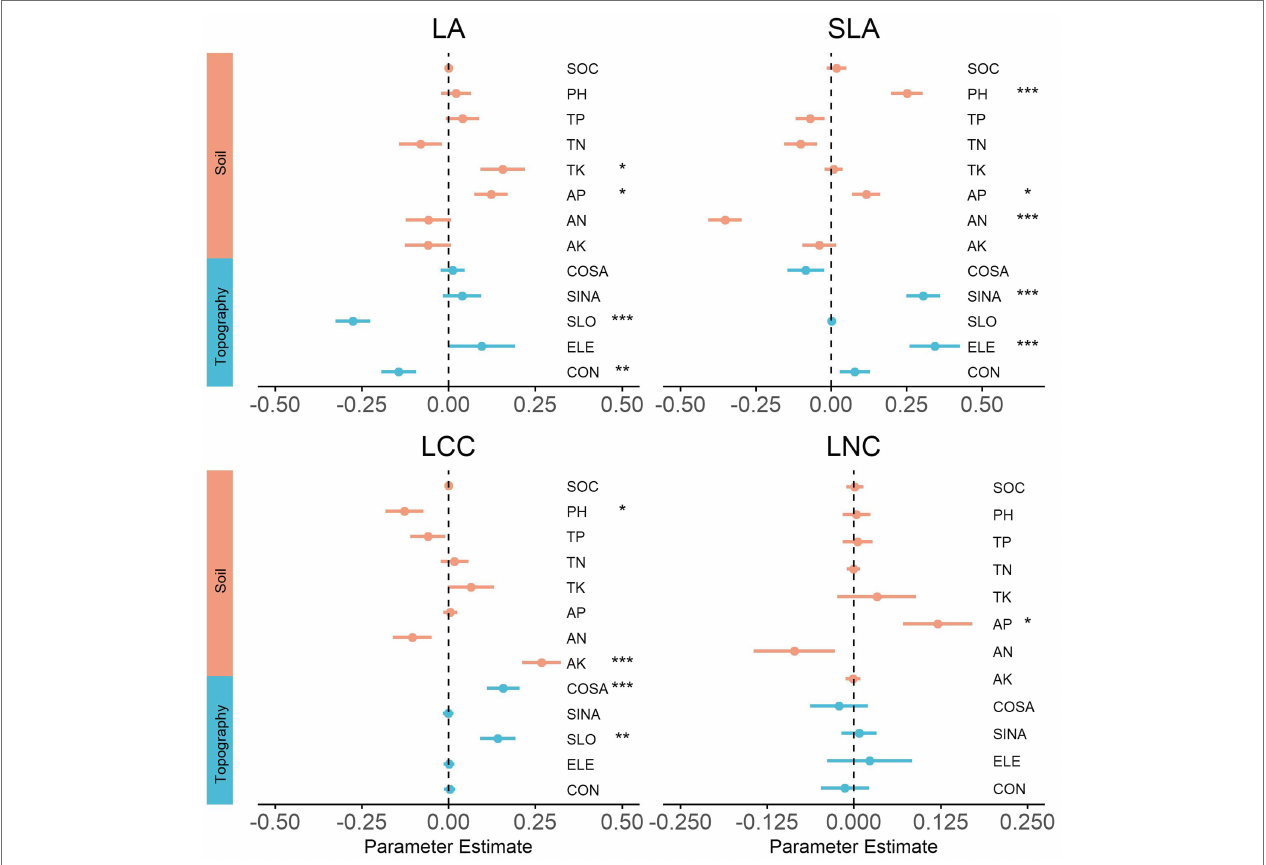
FIGURE 4 | Effects of environmental variables on community functional composition for the local scale. We show the averaged parameter estimates (standardized regression coefficients) of model predictors and the associated 95% confidence intervals. The p -value of each predictor are given as: (.), p < 0.1; * p < 0.05; ** p > 0.01; *** p < 0.001. SOC, organic carbon mass content; PH, soil acidity; TP, total phosphorus; TN, total nitrogen; TK, total potassium; AP, available phosphorus; AN, available nitrogen; AK, available potassium; COSA, North aspect; SINA, East aspect; SLO, slope; ELE, elevation; CON,